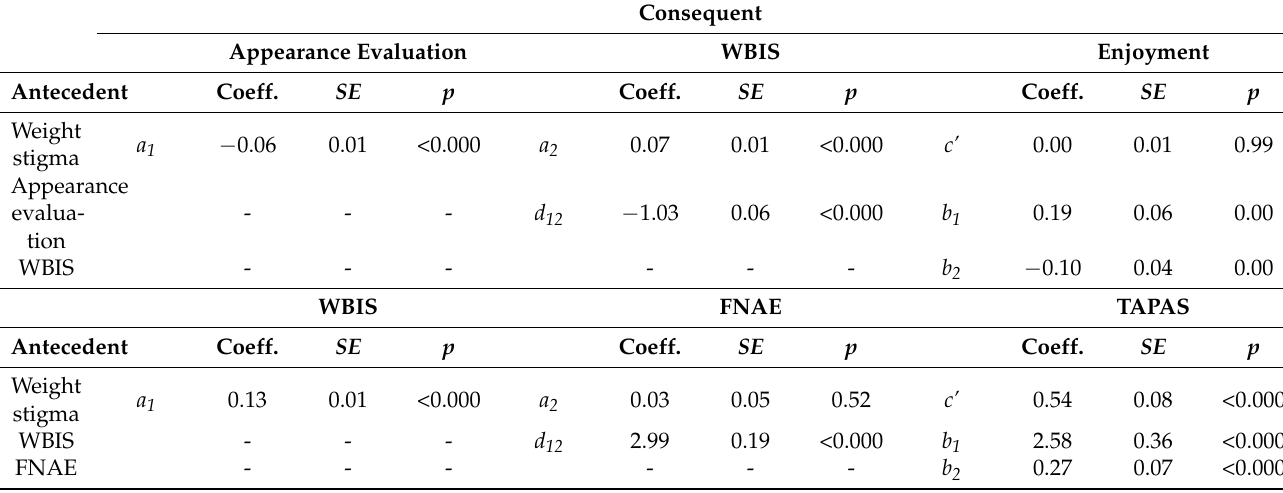
Table 4. Regression coefficients and standard errors for the two serial mediation models presented in Figures 1 and 2 and testing mediating relationships with enjoyment and avoidance of sport and physical activity respectively. All models account for age, BMI, and sex.